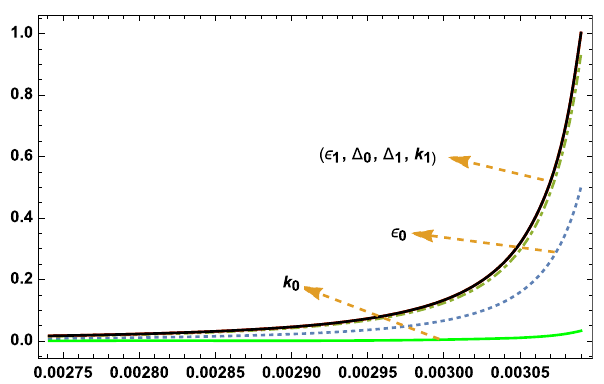
Fig. 6 The variation of (cid:10) 0 , (cid:10) 1 ,... during inflation, for β = 5 × 10 7 , η = 0 . 35 and f = 10 − 3 M p . This behavior is typical of all cases considered and lead to appropriate results for the inflationary indices